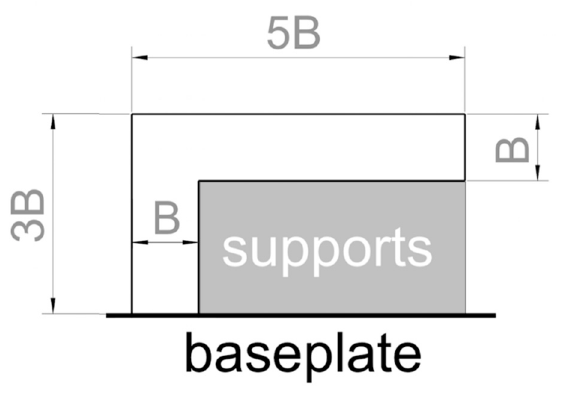
Figure 3. Recommended specimen geometry to be used for the assessment of support parameters.